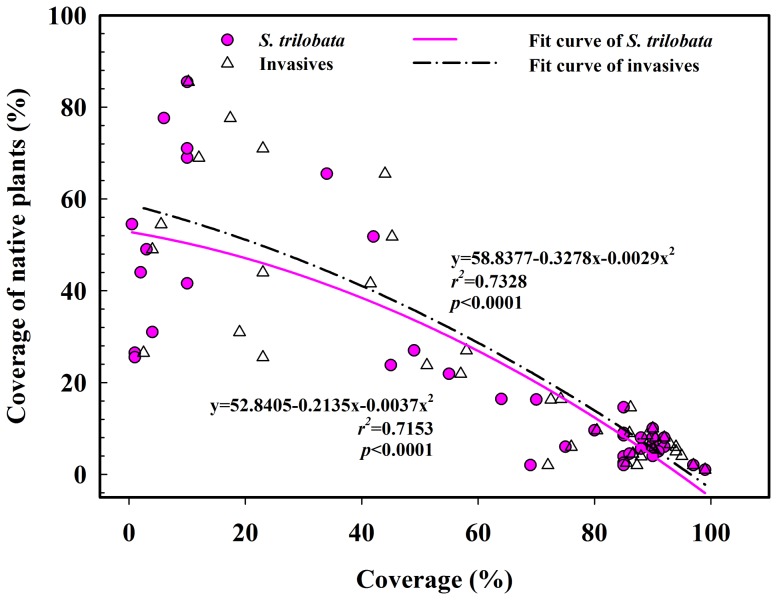
Relationships between the coverage of native plants and both the coverage of S. trilobata and all invasive plants.